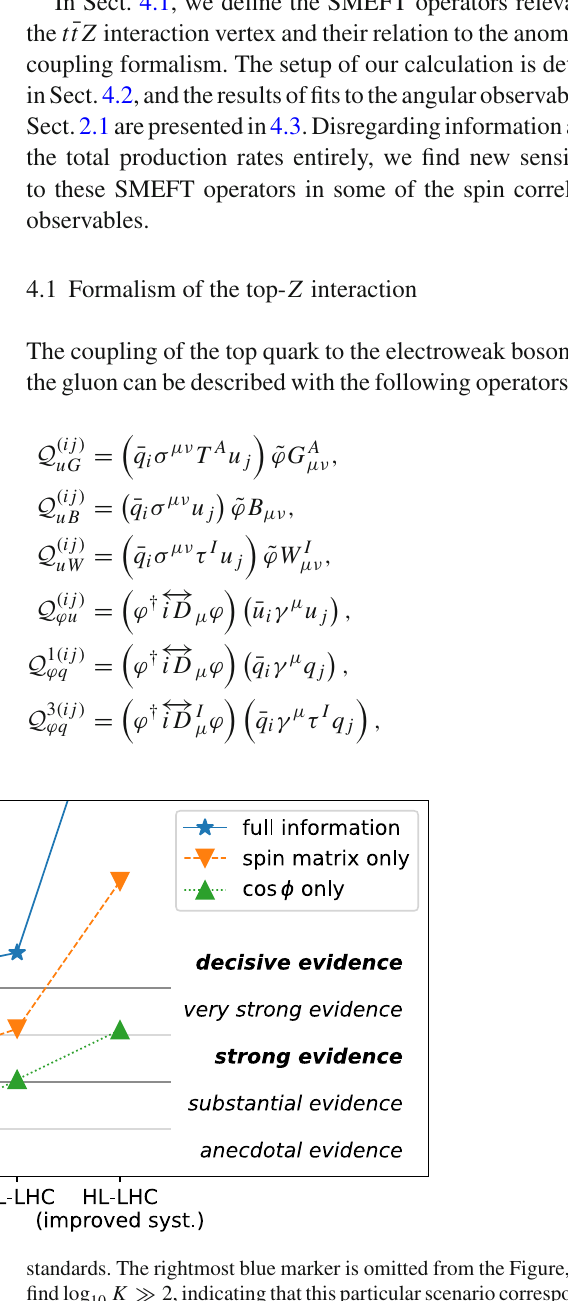
standards. The rightmost blue marker is omitted from the Figure, as we findlog 10 K (cid:14) 2, indicatingthatthisparticularscenariocorresponds to a precision measurement of f SM and clearly rejects the null